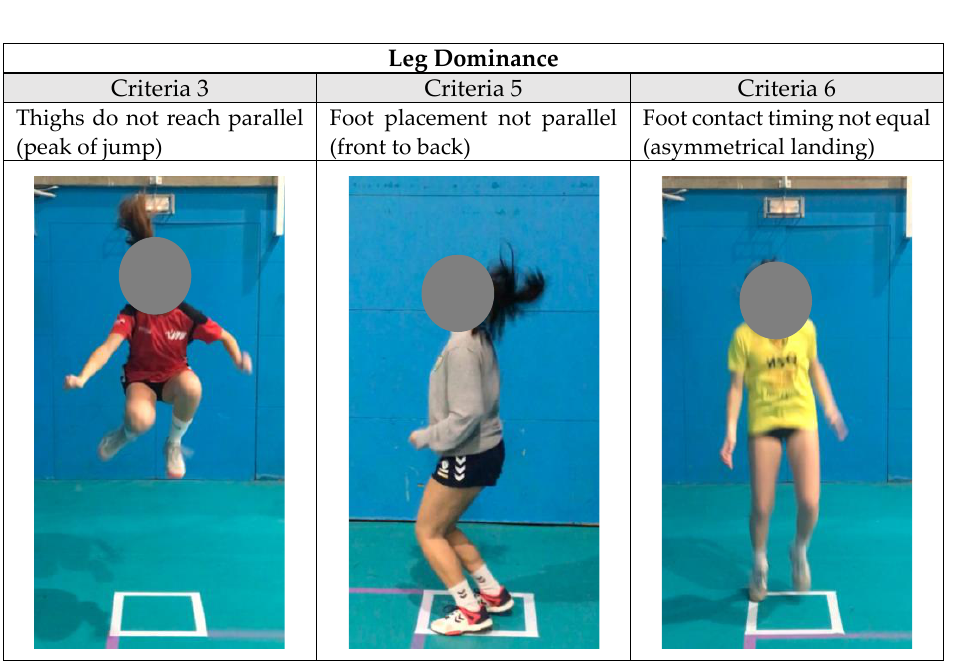
Figure 1. Tuck jump criteria grouped by risk factor category: leg dominance [6]. Two raters (AM and MC), specialists in strength training with more than 10 years of experience and with prior experience in the assessment of the modified TJA, independently analysed and rated each of the criteria of the modified version of the TJA. They were allowed to play the videos as many times as required and at different